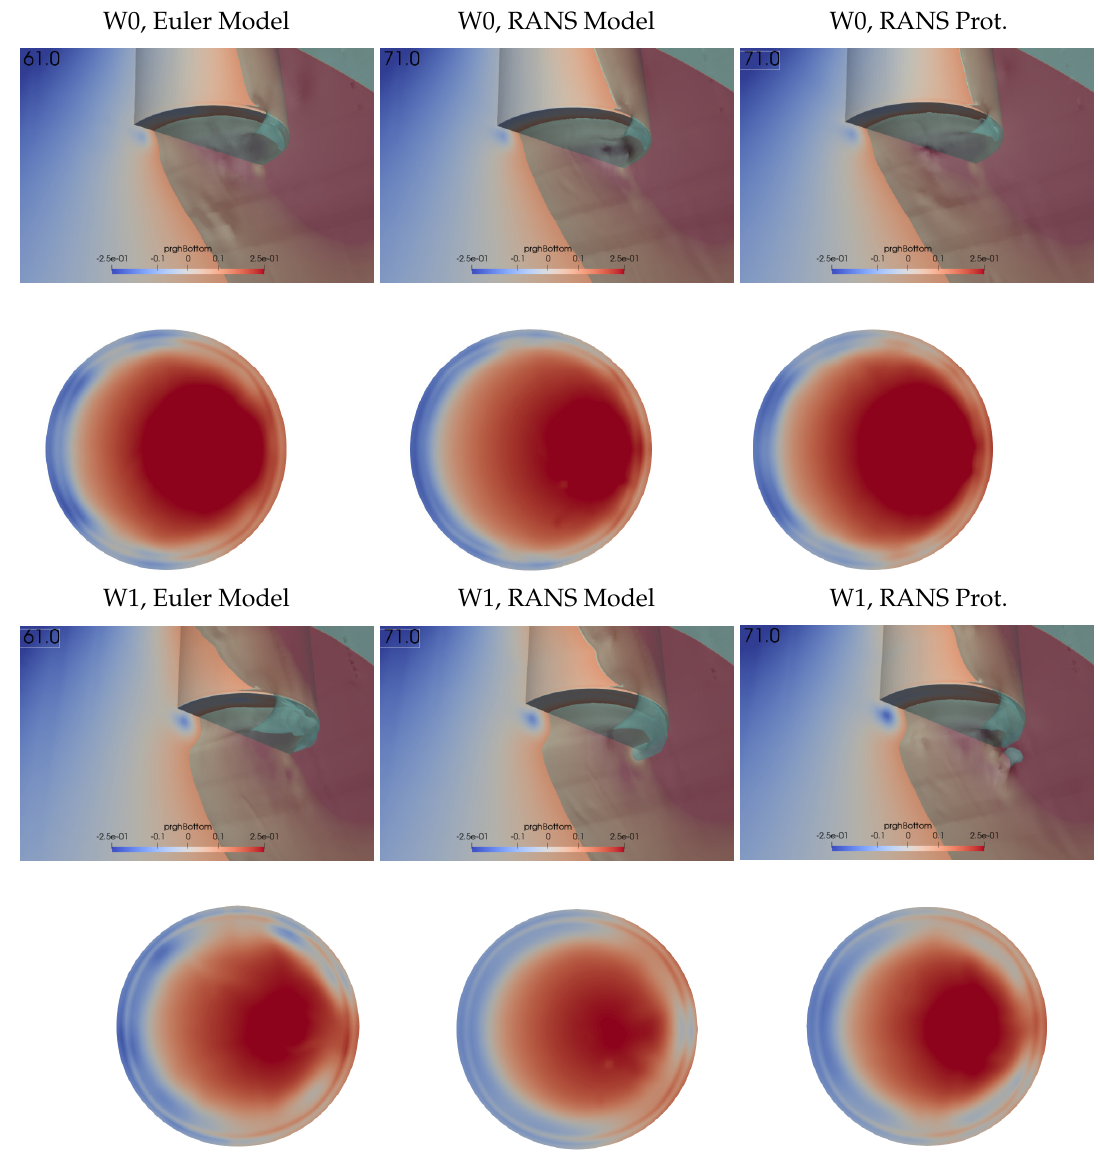
Figure 10. Pressure distribution at the y = 0 plane, including ˜ p = 0.1 iso-surface showing the extent of the vortex influence over dynamic pressure. ˜ p = ( p + ρ gz ) / ( ρ ga ) . Also shown is the corresponding pressure distribution on the WEC bottom. Results are from t ∗ = 12.2 T for the Euler simulation and t ∗ = 14.2 T for the RANS simulations. The colour scale is from blue to red [